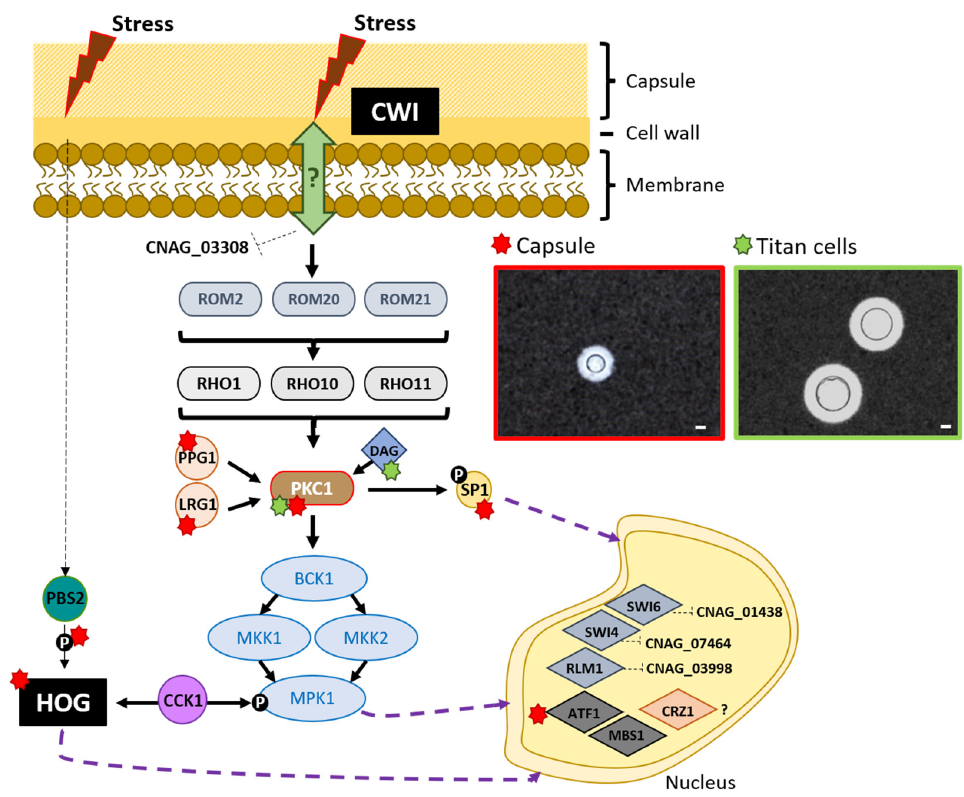
Figure 1. Cryptococcal CWI pathway and its impact on Cryptococcus morphological changes. The complete map of the cryptococcal CWI pathway is still under construction. In Cryptococcus , the plasma membrane are sensors that capture the environmental stress stimuli is not known, being just identified a homologue to Mid2, that is a transmembrane CWI pathway receptor in S. cerevisiae , named CNAG_03308, however, its role in CWI pathway is still unknown. The CWI pathway follows through the interaction with guanine nucleotide exchange factor (GEF), that Cryptococcus presents three homologues Rom2, Rom20 and Rom21, that may activate small GTPases Rho1, Rho10 and Rho11, which activates Pkc1, that is regulated by Ppg1 and Lgr1. Besides the small GTPases, DAG is also able to activate Pkc1. Pkc1 will be responsible to continue the pathway through regulation of the MAPK (mitogen-activated protein kinase) cascade (Bck1, Mkk1, Mkk2 and Mpk1) essential to the cell wall maintenance. Besides this, Pkc1 is also important to the phosphorylation of the cryptococcal transcriptional factor Sp1, important to regulate virulence factors expression in Cryptococcus . At the end of the pathway, several transcription factors (represented in the nucleus) will control the expression of factors that will work on the maintenance of the cell wall integrity. In Cryptococcus , some integrants of the CWI pathway are important for morphological changes that cryptococcal cells suffer during the interaction with host: capsule (red signal) and Titan cells (green signal) formation. Some factors such as Cck1 connect CWI pathway to other cell wall integrity pathway HOG, whose factors also contribute to morphological changes in Cryptococcus . In the figure, the bars represent 20 µm. This figure was elaborated based on [18,27,28].